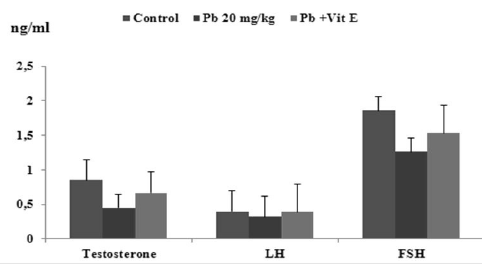
Fig. 2. Serum levels of testosterone, LH and FSH after intra- peritoneal lead acetate. The values expressed as m ean ± SEM (n=10). * p0, 05**; p<0, 01